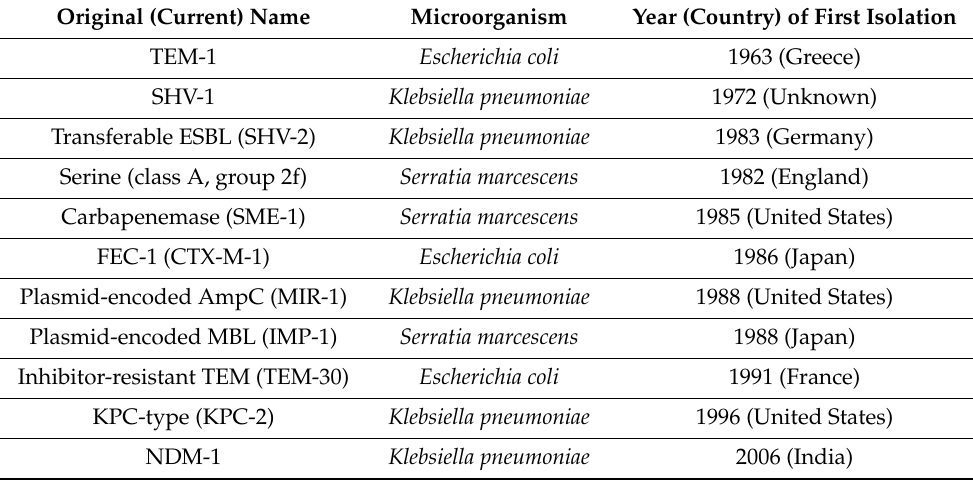
Table 1. Overview of most important β -lactamases and relative microorganisms at their first appearance (adapted from reference 10 with